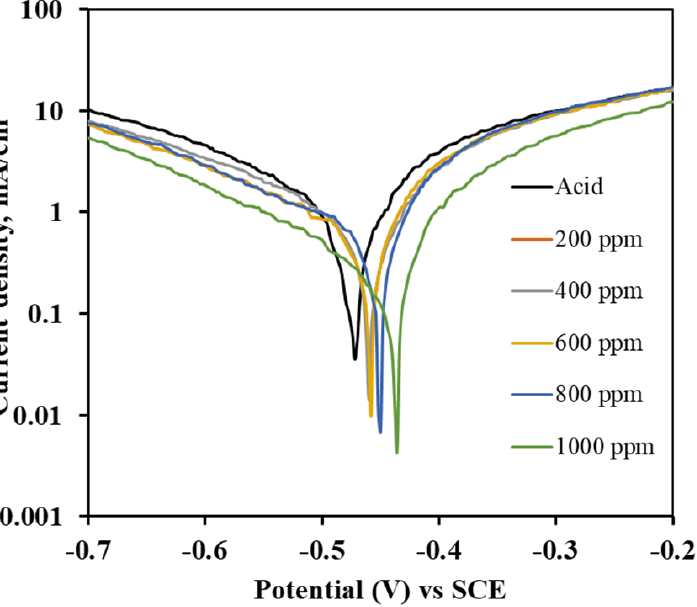
concentrations of AV alkaloids as-immersed condition.